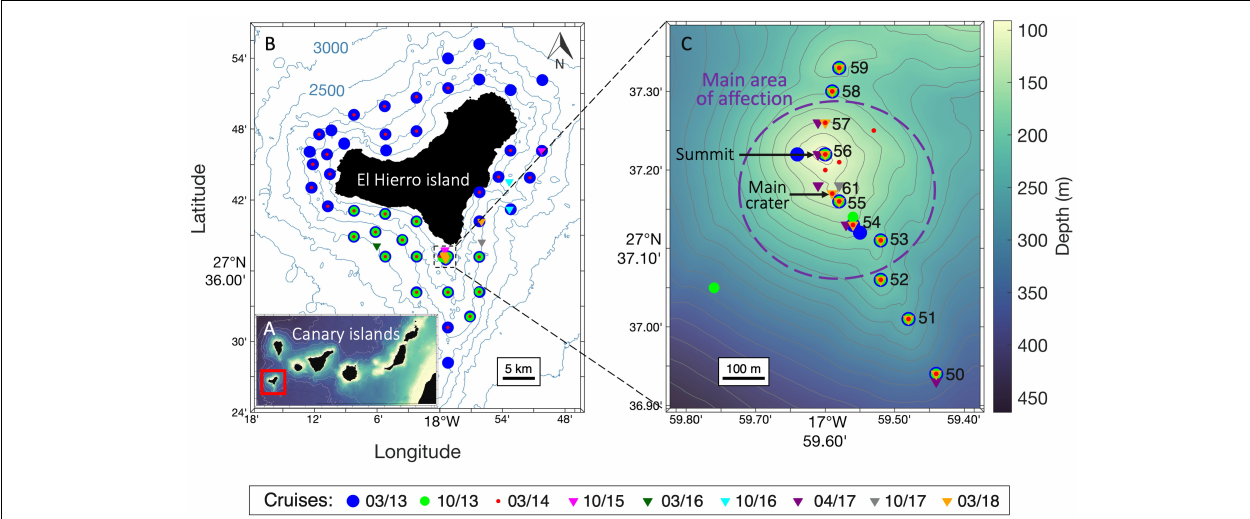
FIGURE 1 | Study location and month-year cruises. (A) Map of the Canary Islands. (B) Map of the island of El Hierro with stations carried out during all cruises. (C) High-resolution bathymetry of the volcanic edifice and high-resolution transect (“subnet;” stations 50-59 and 61) carried out across the main cones. All maps were generated using Matlab 8.5